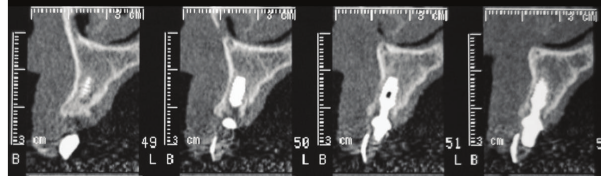
Figure 11: CT scans three weeks after surgery. Note the absence of vestibular bone dehiscence.